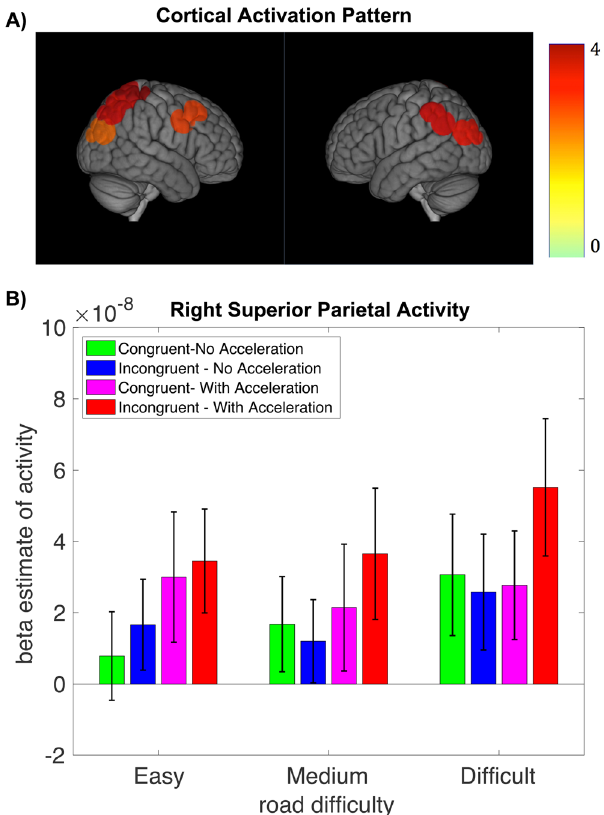
Figure 3. Profile of cortical brain activity. ( A ) The cortical regions with significantly greater activity in task compared with control (p < 0.05, FDR corrected). ( B ) The mean (standard error) of beta estimate of activity in the right superior parietal region across conditions. The green (pink) bars indicate congruent steering with (w/o) acceleration and blue (red) bars indicate incongruent steering with (w/o)